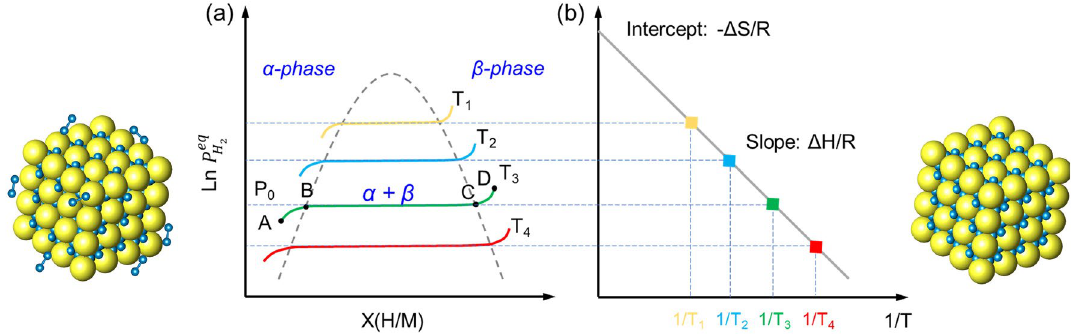
Fig. 1 a Pressure–composition isotherm plot of Mg ⇄ MgH Mg + H 2 2 . The enthalpy and entropy of hydrogenation and dehydrogenation could be obtained from the slope and intercept, respec- tively. Schematic representations of the α-phase (left) and β-phase (right) of metal hydride are also